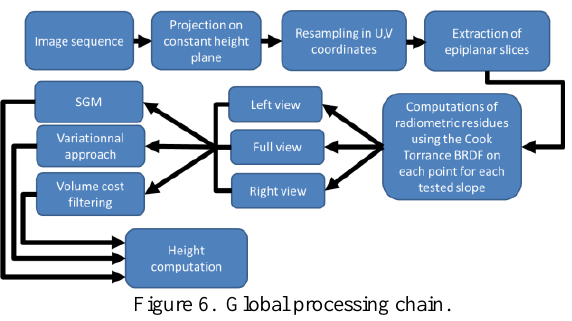
Figure 6. Global processing chain.